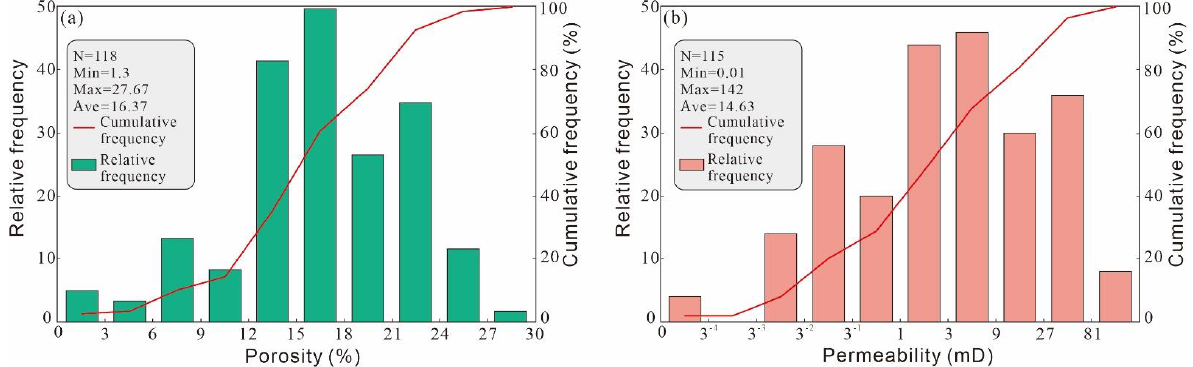
Figure 7. Histogram and line charts exhibiting the reservoir properties of the Jiucaiyuan Formation in the Beisantai Uplift. ( a ) Relative and cumulative frequency of porosity. ( b ) Relative and cumula- tive frequency of